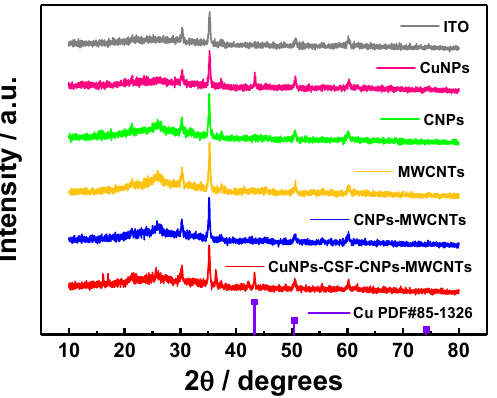
Figure 3. XRD patterns of ITO, CuNPs, CNPs, MWCNTs, CNPs-MWCNTs and CuNPs-CSF-CNPs- MWCNTs, respectively.